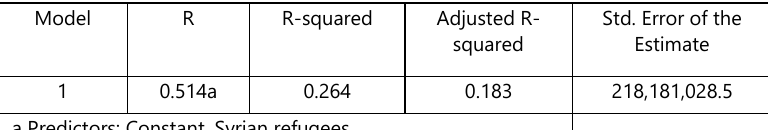
Table 3: Model Summary (Source: Author‘s research 2022)